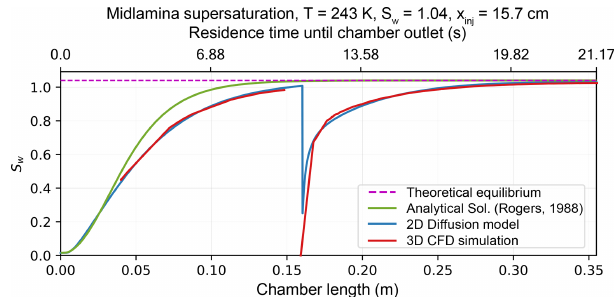
Figure A4. Comparison of the mid-lamina water supersaturation at T = 243K, as calculated using the analytical formula (Rogers, 1988), simulated using the 2-D diffusion model and the 3-D CFD simulation. Injector position x inj = 15 .